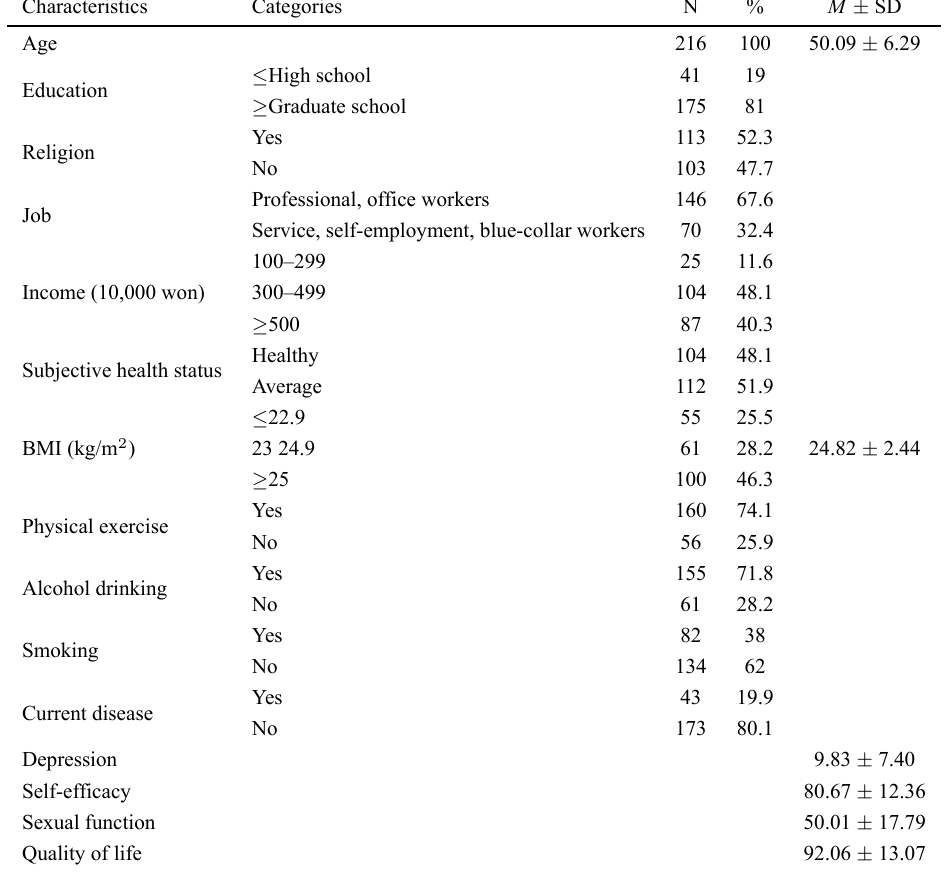
Table 1. General characteristics and depression, self-efficacy, sexual function, quality of life (N = 216).